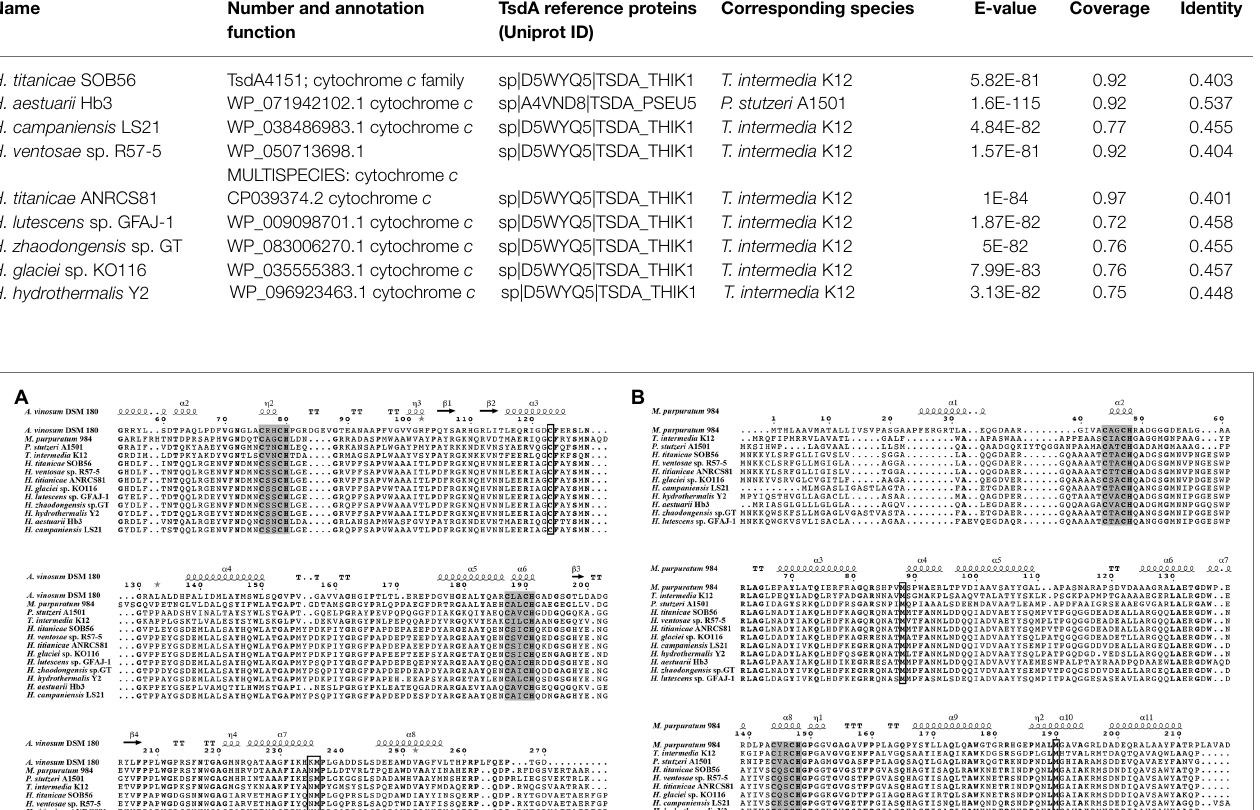
TABLE 2 | Homologous proteins of TsdA in Halomonas